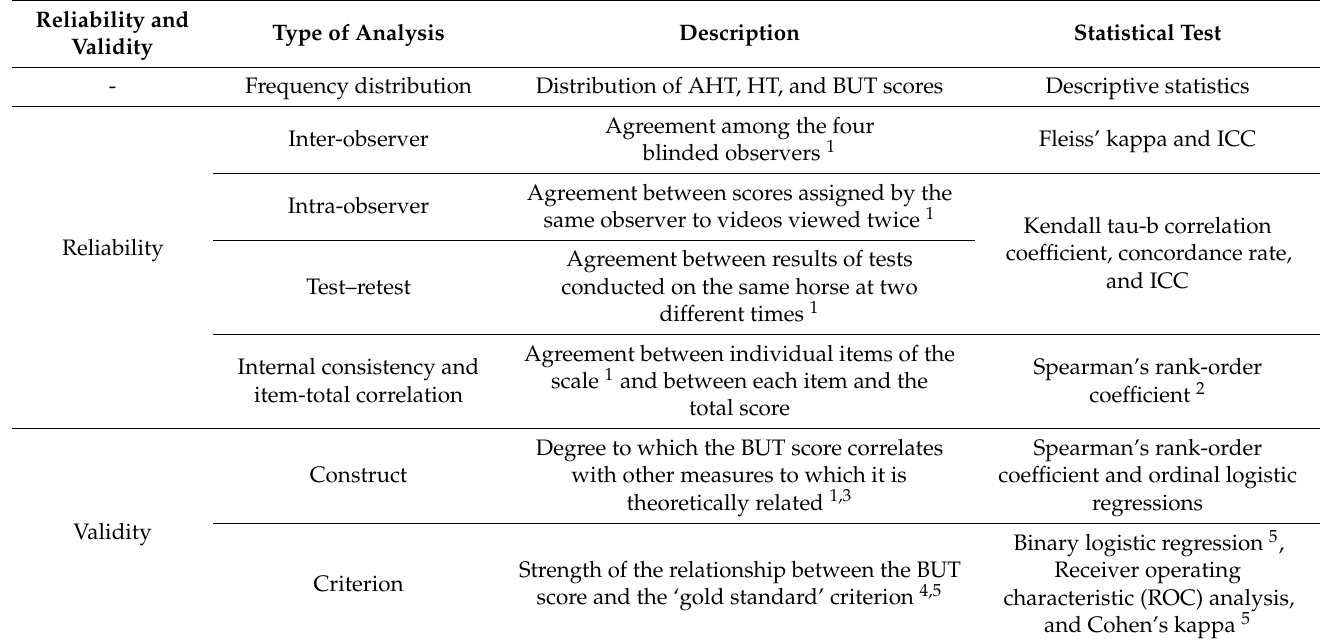
Table 2. Statistical methods for validation of the Broken/Unbroken